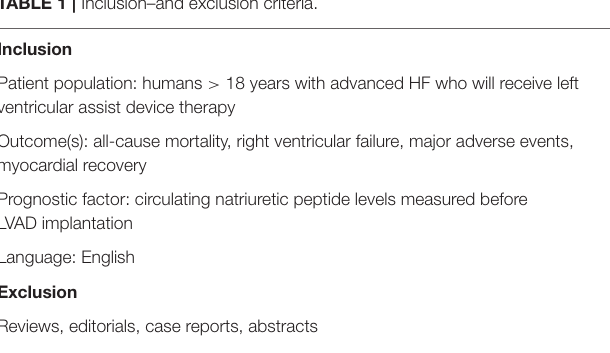
TABLE 1 | Inclusion–and exclusion